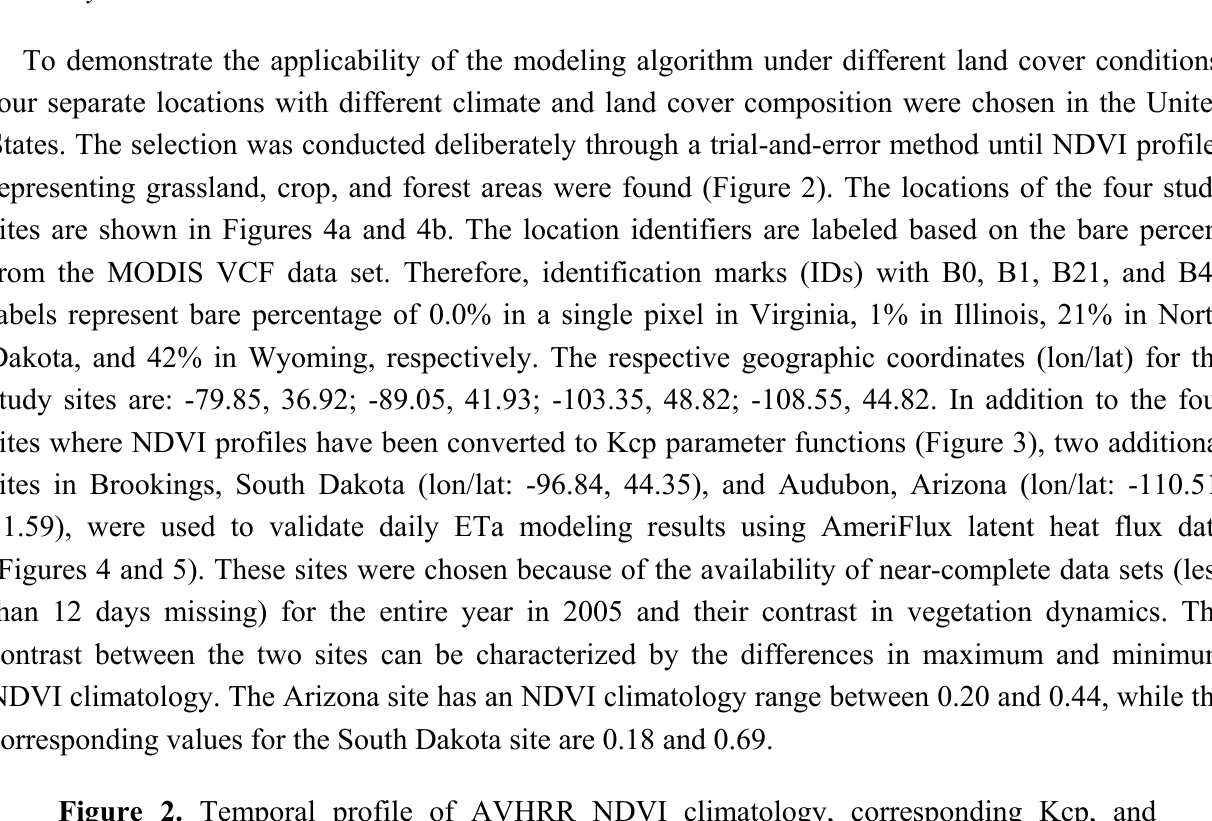
Figure 2. Temporal profile of AVHRR NDVI climatology, corresponding Kcp, and control Kc profiles for two potential cropland locations with different proportion of bare (B), herbaceous (H), and tree (T) cover percentages. NDVI_1: B = 1%, H = 72%, T = 27%; NDVI_2: B = 21%, H=77%,